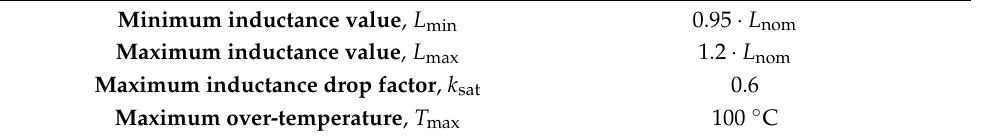
Table 3. Parameters adopted in the feasibility constraints of the design problem.